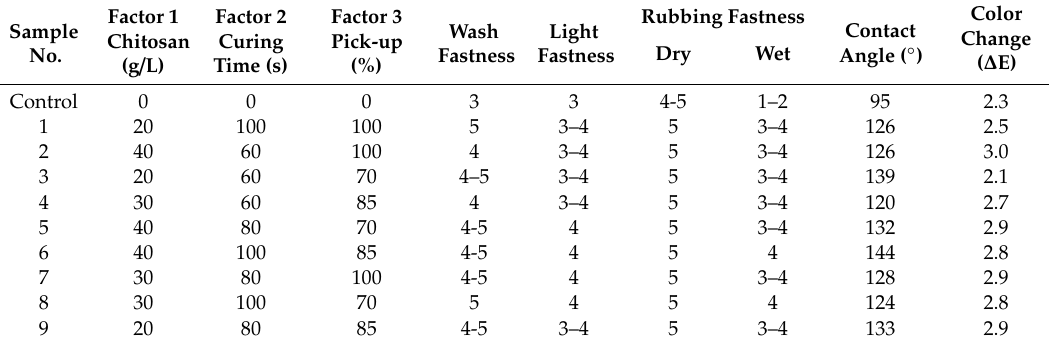
Table 3. Wash fastness values and contact angles of the post-treated fabrics, and the color change caused by each